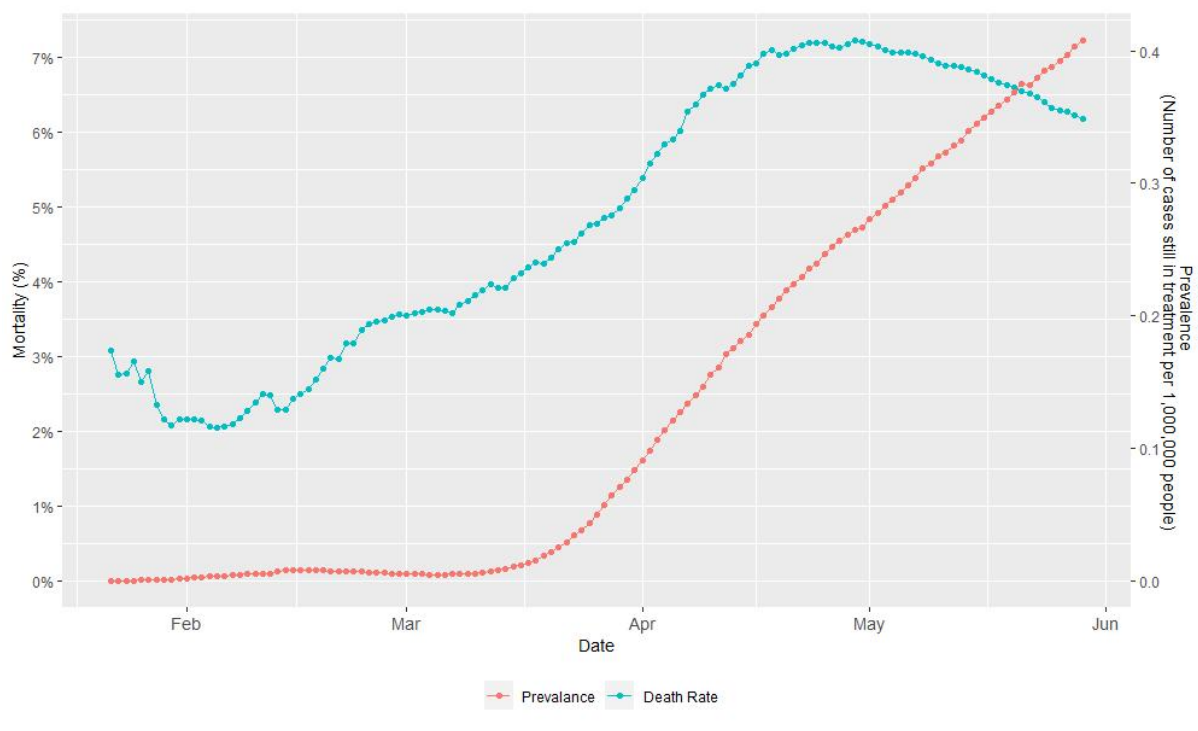
Figure 2. Trends of global COVID-19 mortality and prevalence over